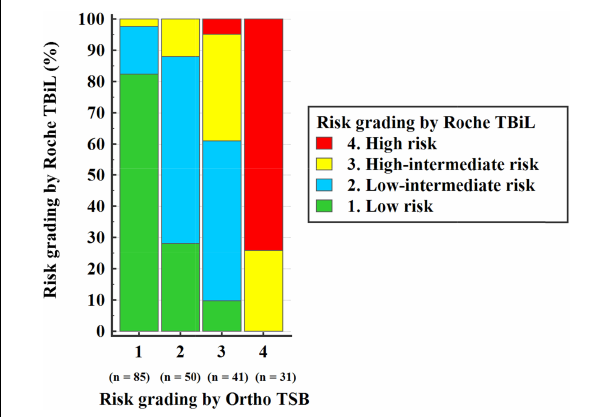
FIGURE 3 | Subsequent neonatal hyperbilirubinemia risk grading by Roche TBiL and Ortho